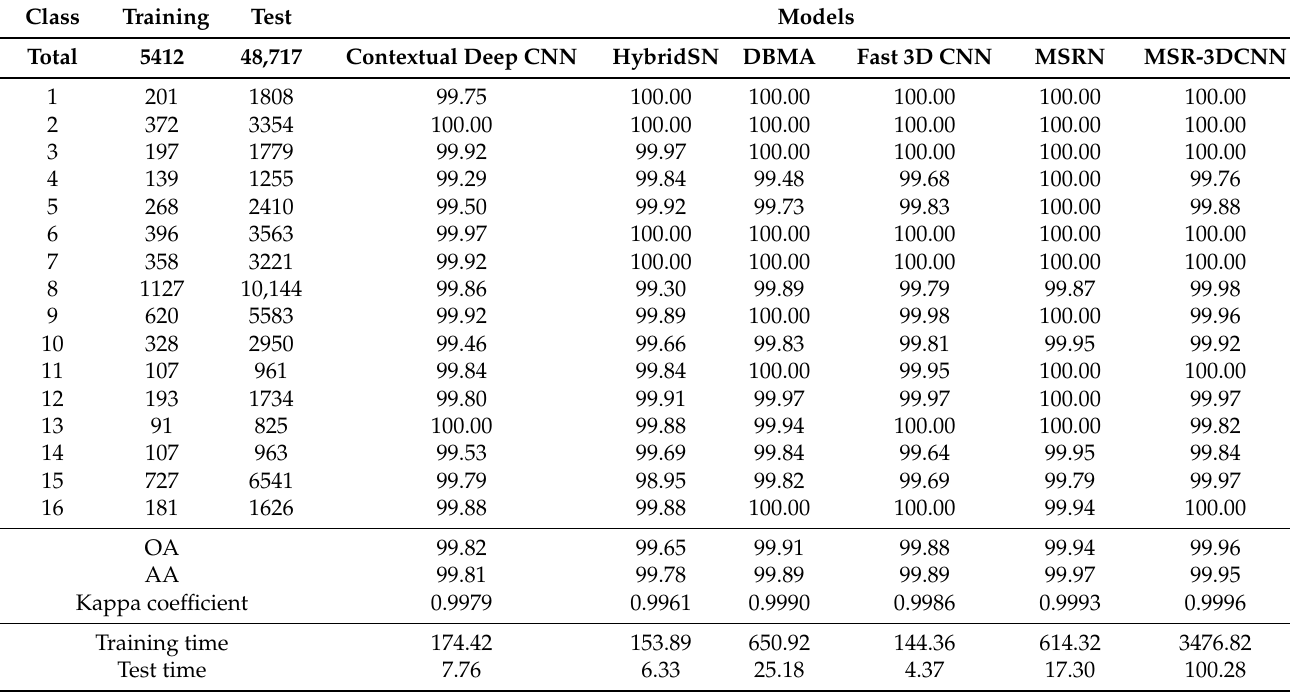
Table 5. F1 Score (%) for each class, OA (%), AA (%), and Kappa Coefficient values for the entire dataset, training time (s), and test time (s) using ( 9 × 9 ) patch size and 10% samples for training on the SA dataset.